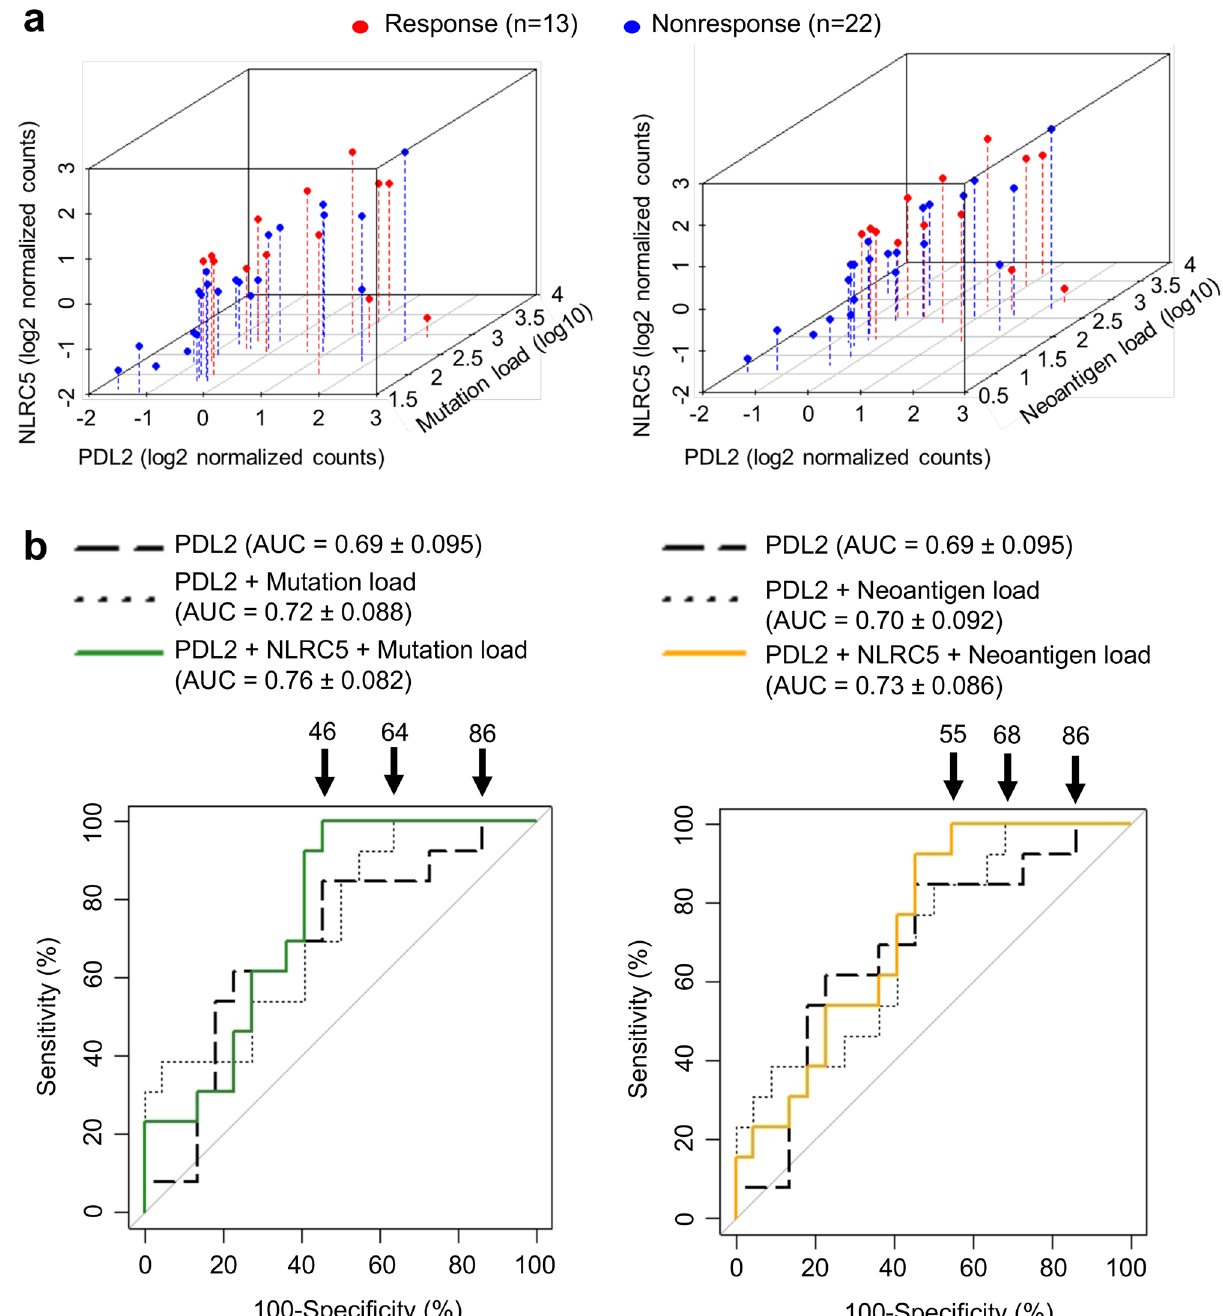
Figure 3. Combination of PD-L2 expression with NLRC5 expression and mutation or neoantigen load are sensitive predictors for responses to anti-CTLA-4 therapy. ( a ) Scatterplots for NLRC5 and PD-L2 expression with mutation load (left panel) or neoantigen load (right panel) for response (n = 13) and nonresponse (n = 22) groups. ( b ) ROC curves for logistic regression models using the respective combination of PD-L2 expression, NLRC5 expression, mutation load and neoantigen load. The numbers with arrow are showing false positive rate with 100% sensitivity. AUC (area under the curve) ± SE (standard error) is